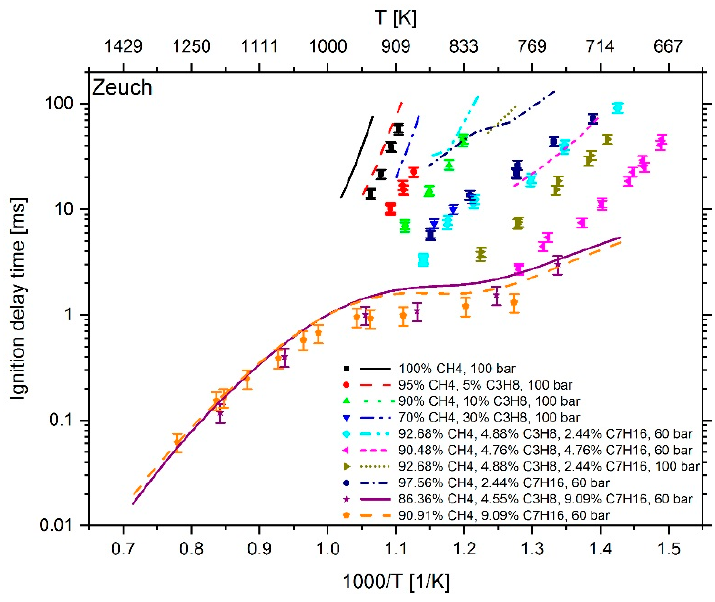
Figure 8. Experimental data (symbols) [6,7] versus model prediction (lines) using the n -heptane skeleton mechanism of Zeuch et al. [25].